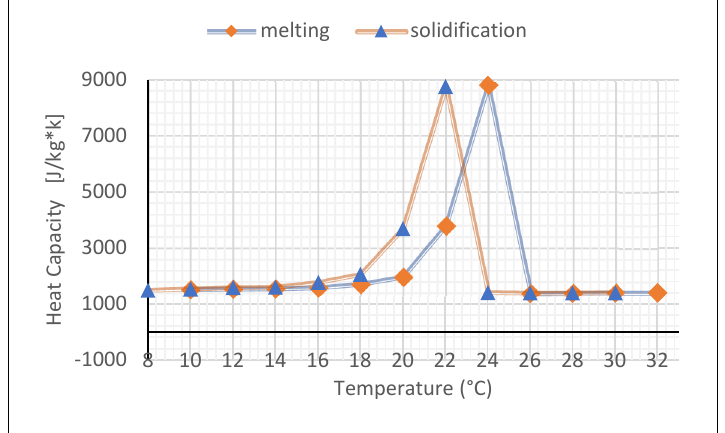
Figure 4. Thermal capacity of Micronal ® PCM SmartBoard™ 23 for melting and cooling stages.